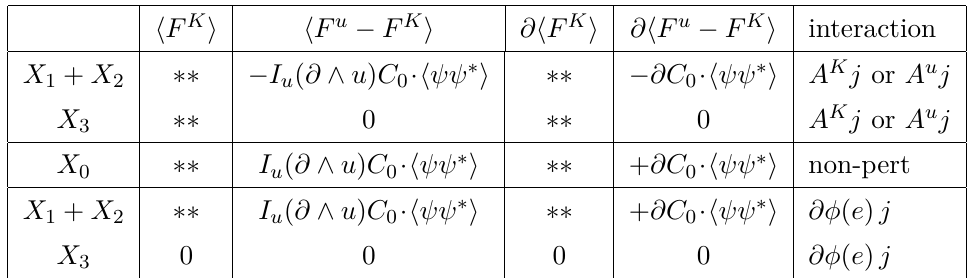
In the perturbative approach, this was already one of the main messages of [57]: the string- localized total interaction q A ( c ) j (in Wigner space or in Krein space) yields the correct Gauss Law without a fictitious source term compensating the total